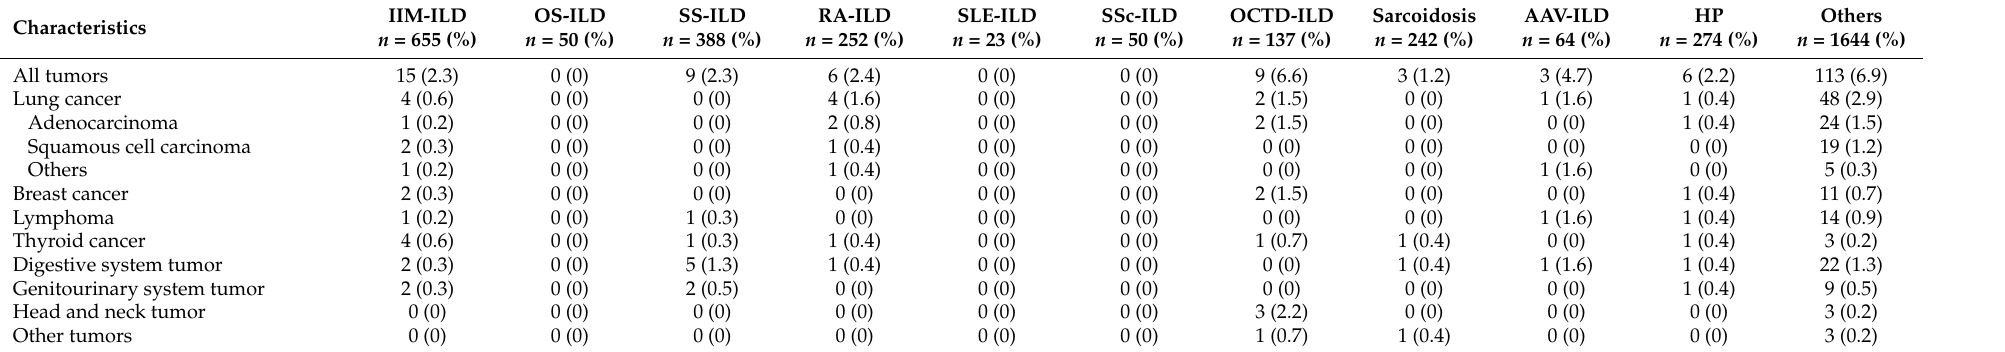
Table 6. Demographic characteristics and prevalence of malignancies in CTD-ILD and other types of ILDs.